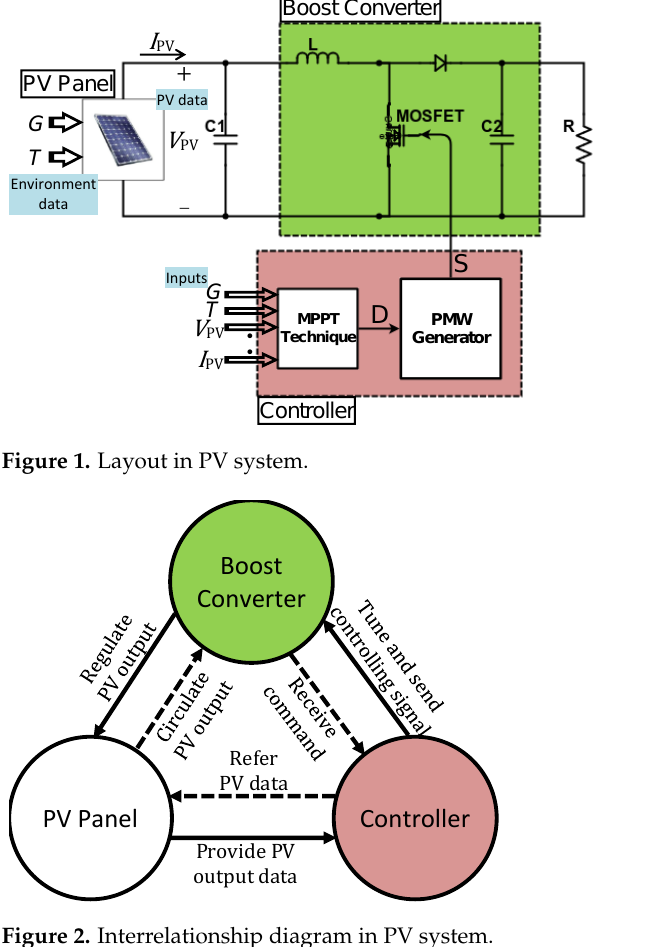
Figure 2. Interrelationship diagram in PV system.